Question: Write the caption for this figure.
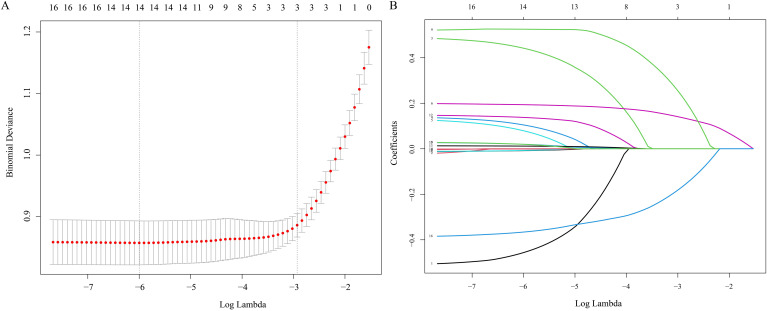
Answer: LASSO regression for candidate variable selection in the atrial fibrillation classification model. (A) Selection of the optimal penalty parameter (λ) by cross-validation; (B) LASSO coefficient profiles of candidate variables.